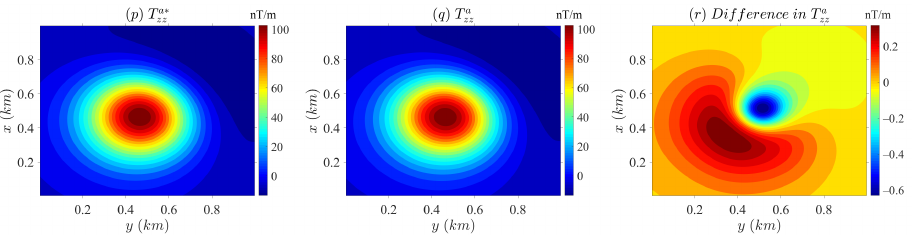
Figure 5. Surface anomalous magnetic gradient fields produced by a magnetic spherical shell with susceptibility of 50 SI. T a ∗ xx , T a ∗ xy , T a ∗ xz , T a ∗ yy , T a ∗ zz , T a ∗ yz denote the analytical solutions,